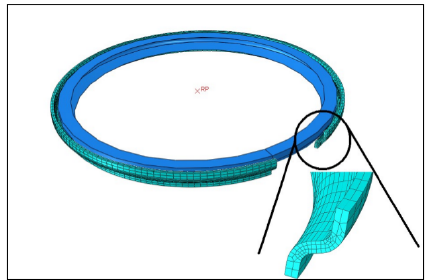
Figure 3: Three dimension finite element model of V-band and flange.